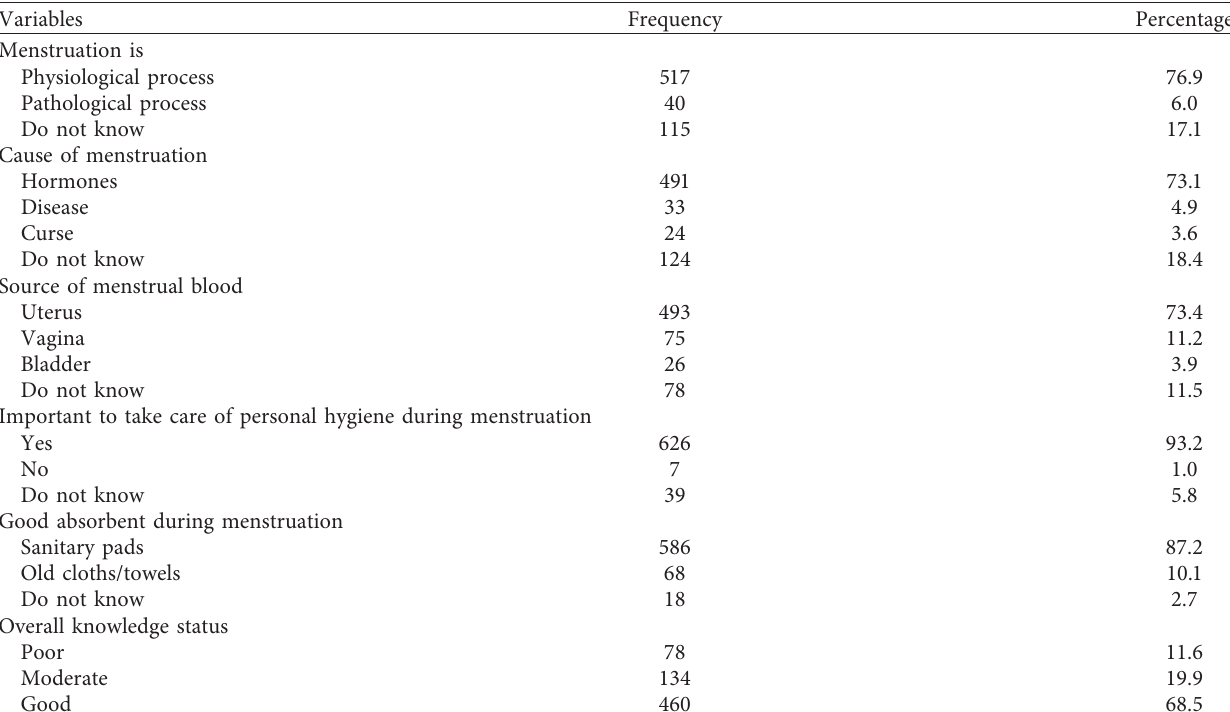
Table 2: Knowledge of menstruation and its hygiene practices among secondary school girls in East Hararghe Zone, Ethiopia, 2017 ( n �